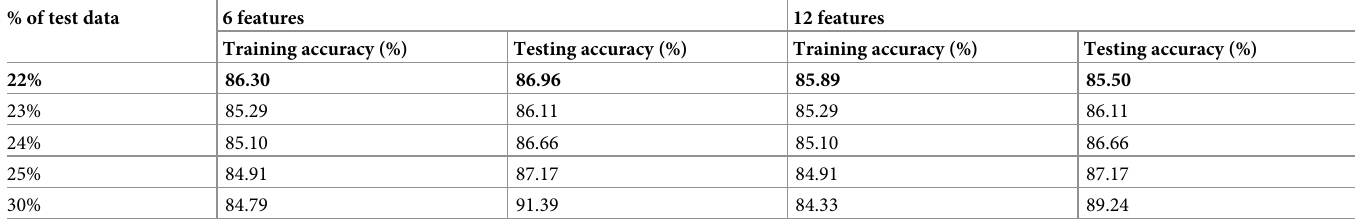
Table 6. Results for different proportion of test samples for SVM. % of test data 6